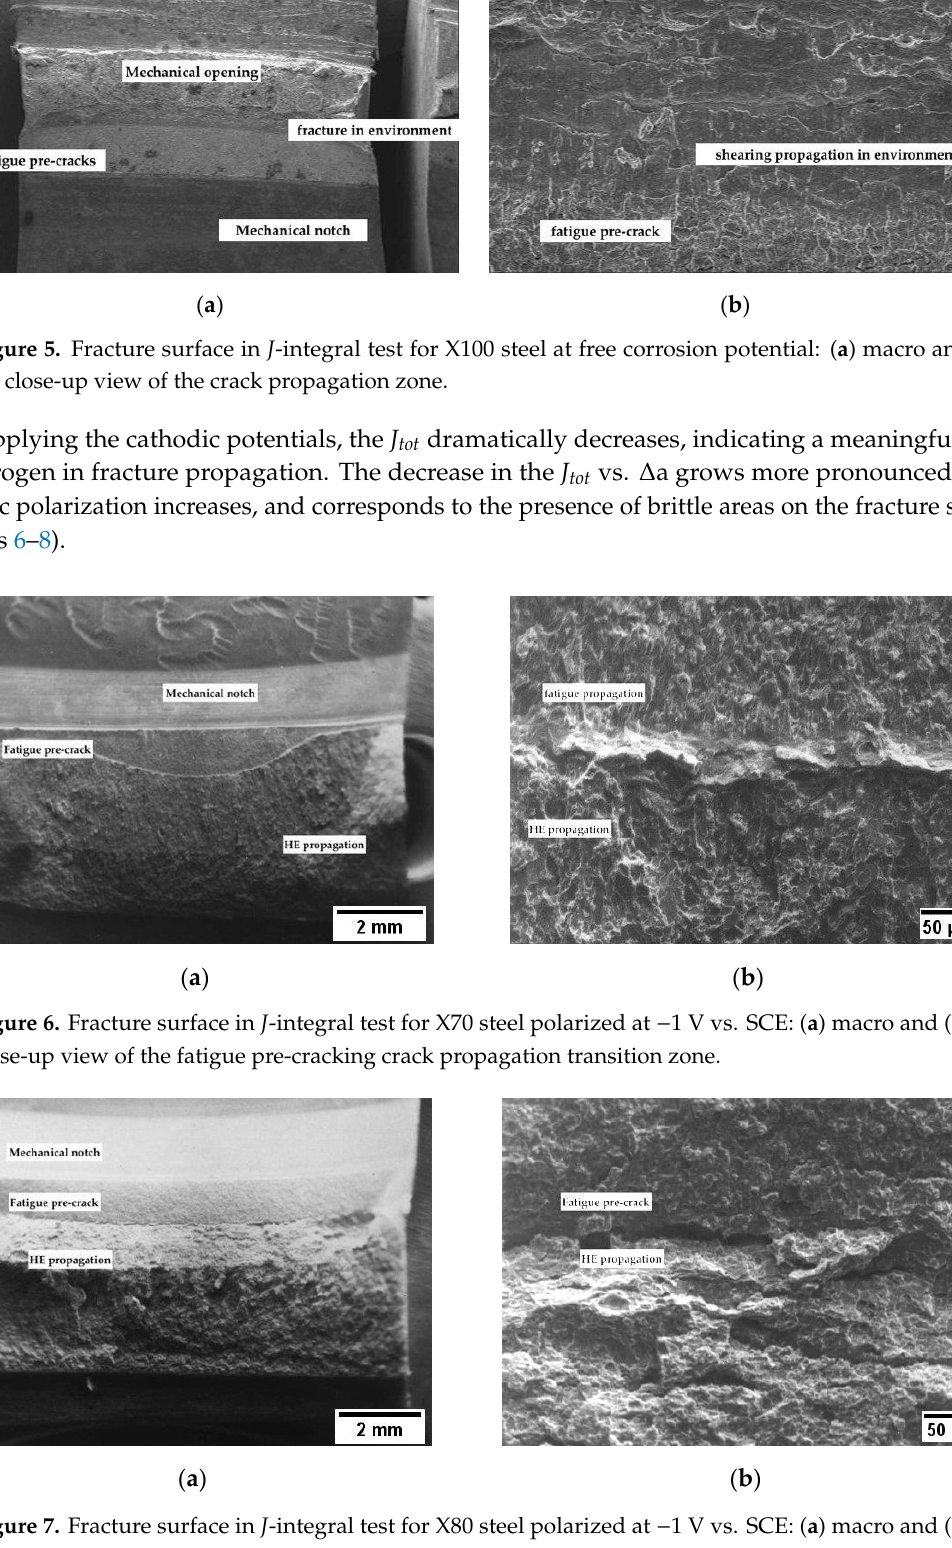
( b ) Figure 8. Fracture surface in J-integral test for X100 steel polarized at −1 V vs. SCE: ( a ) macro and ( b ) close-up view of the crack propagation zone. The peak values of the crack growth obtained in NaCl 3.5% solution were higher than those obtained in air, and increase with the increasing of cathodic polarization of the specimens, as shown in Figure 10. The crack growth rate in air increases with the increasing of the tensile resistance of the steels. The maximum crack growth rate of 30NiCrMo12 steel was markedly higher than that of the three pipeline steels. At the same time, in NaCl 3.5% solution, the crack growth rate was higher than in air, and further increases were observed when the specimens were cathodically protected.